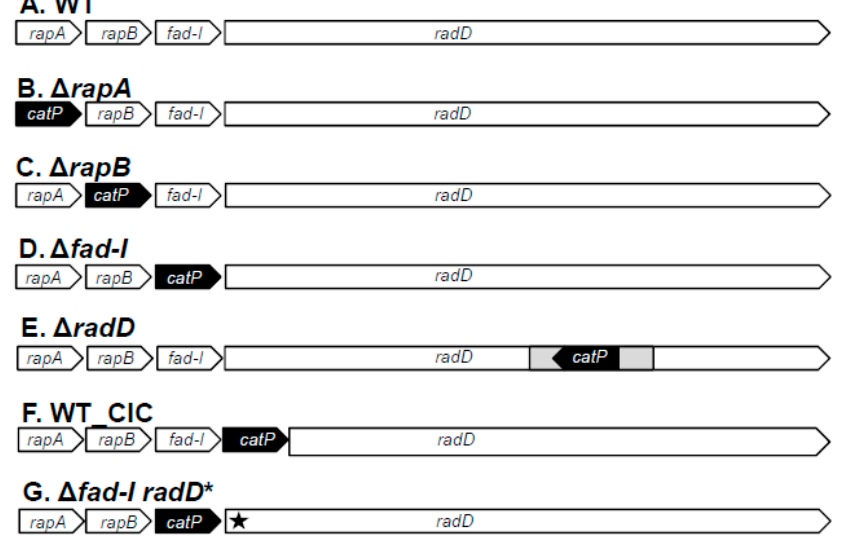
Figure 1. Schematic representation of gene inactivation mutants of the radD -encoding four-gene operon and controls ( A ) wild-type (WT), ( B ) ∆ rapA , ( C ) ∆ rapB , ( D ) ∆ fad-I , ( E ) ∆ radD ( F ), and wild-type- catP insertion control (WT_CIC) in F. nucleatum subspecies nucleatum and polymorphum . ( G ) ∆ fad-I radD *: F. nucleatum ssp. nucleatum ATCC 23726 radD frameshift mutant in the ∆ fad - I background.